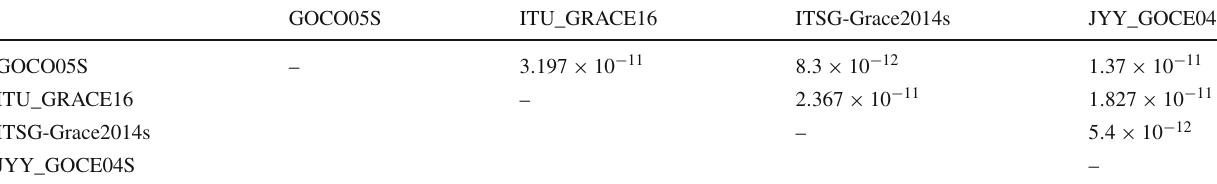
Table 4 Percent uncertainty δμ ( % ) due the errors in C LT according to Table 3